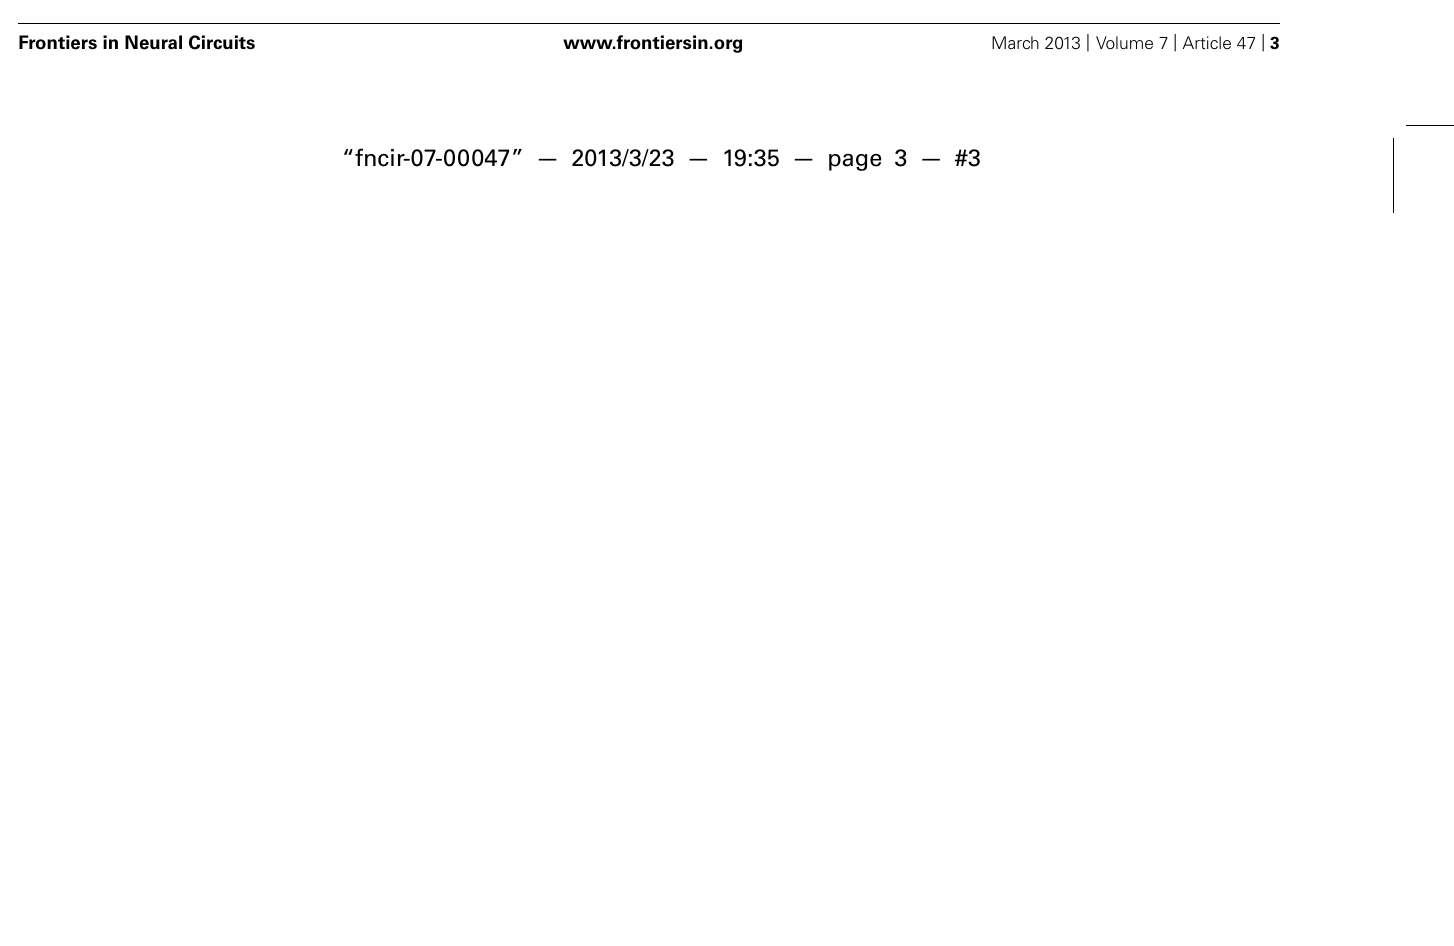
FIGURE 1 | Development and organization of the posterior lateral- line sensory receptors. (A) Lateral view of a developing zebrafish at around 30, 48 hpf and 7 dpf (days post-fertilization) showing the development of the mechanoreceptive neuromasts that form the posterior lateral line. primI, first primordium; primII, second primordium; primD, dorsal primordium. ( > ) and ( ∧ ) indicate parallel and perpendicular neuromasts, respectively. (B) Lateral view of a neuromast.The hair-bundle comprises the kinocilium (K) and the stereocilia (S), and is contained within a gelatinous cupula. A